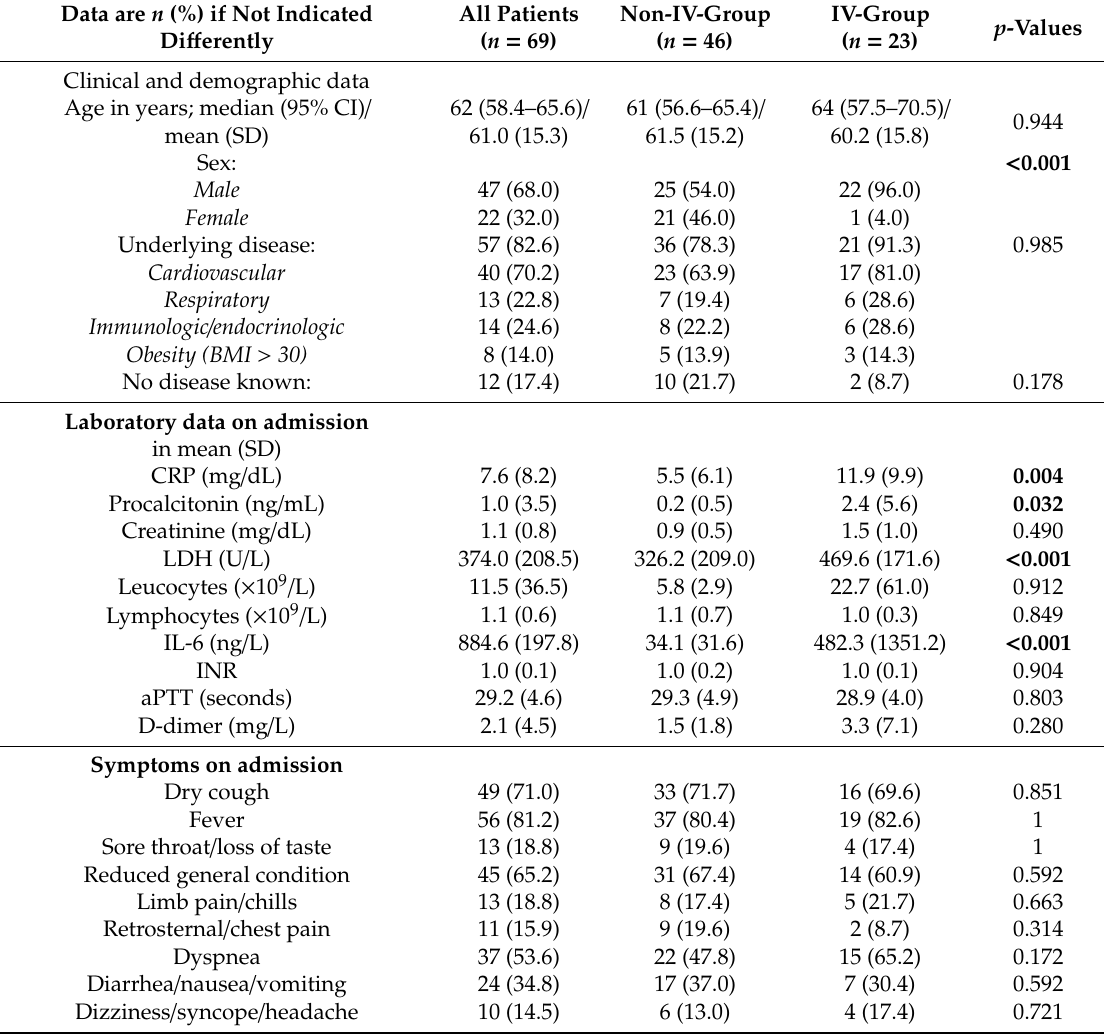
Table 1. Demographic data, clinical characteristics and epidemiologic features of our study cohort. Data are n (%) if Not